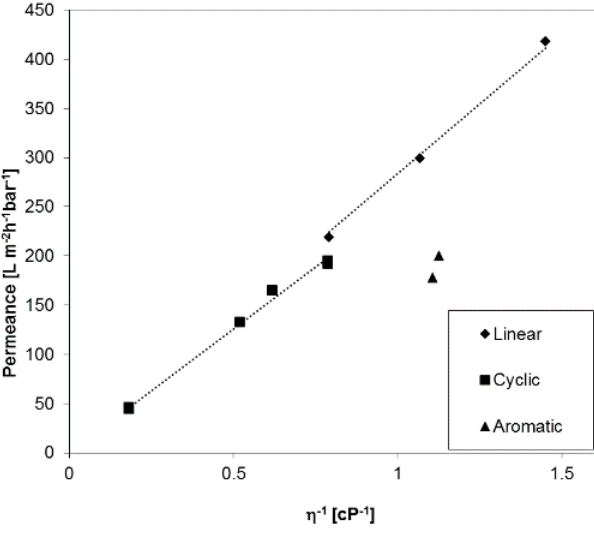
Figure 6. Permeance of a PAN membrane against reciprocal viscosity of linear, cyclic, and aromatic PF compounds.